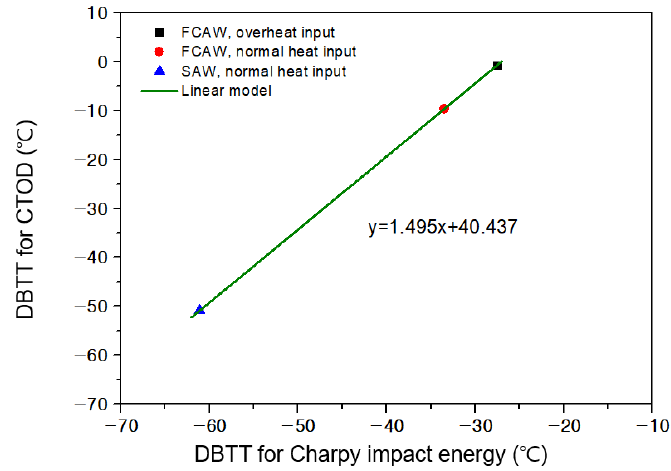
Figure 9. Relationship of DBTT between CTOD and Charpy impact tests.